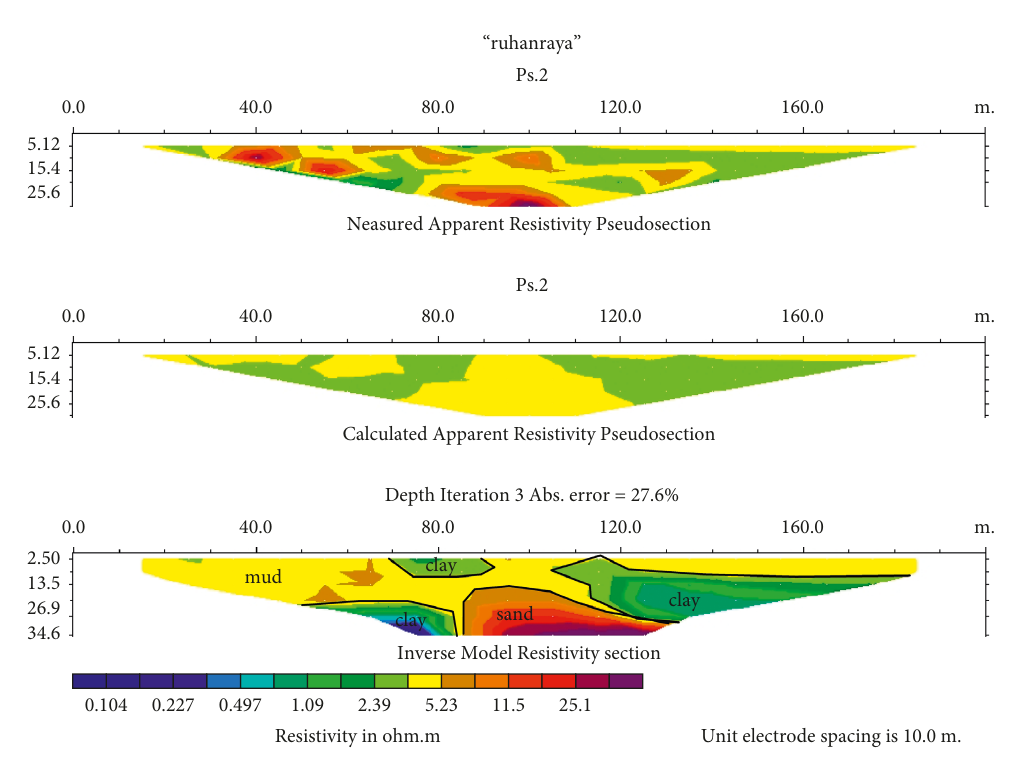
Figure 5: Electrical resistivity 3D imaging at Limb of Peat Anticline (source: primary data, 2012).